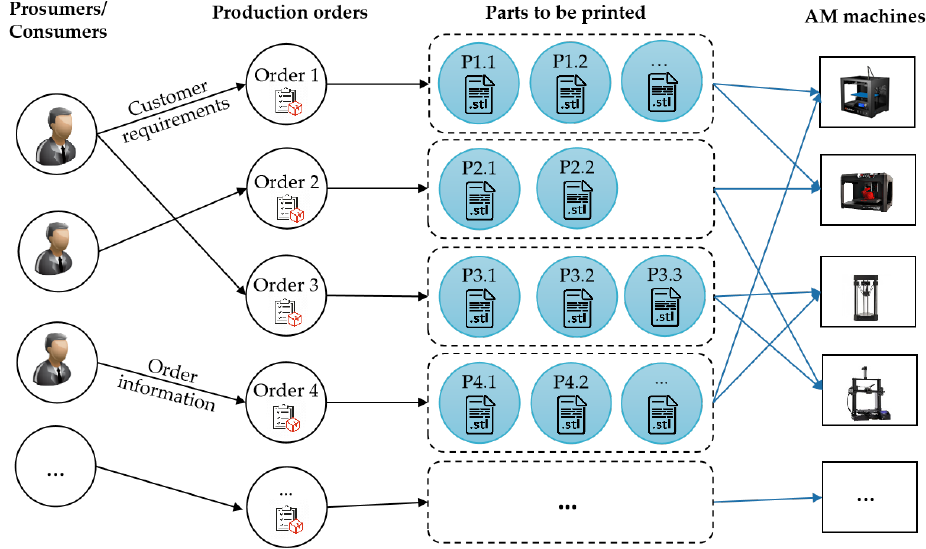
Figure 1. Concept model for AM production planning in SocialMfg.